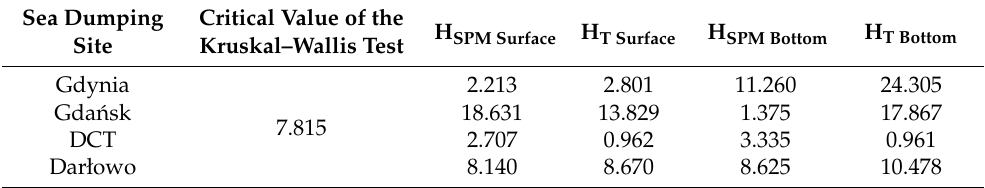
Table 6. Kruskal–Wallis test results. For H values higher than the critical value, we rejected the null hypothesis that there were no statistical differences between the measurements at different times of the year. For lower values, there was no reason to reject this